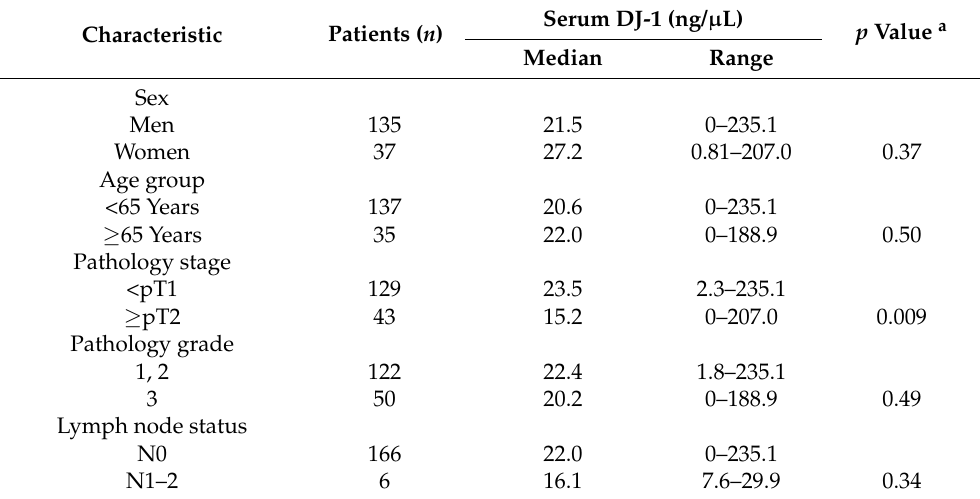
Table 1. Relationship of DJ-1 serum concentration with the clinicopathologic characteristics of 172